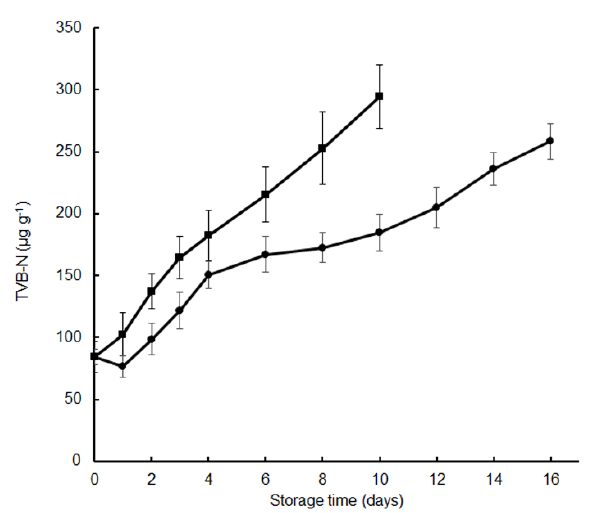
Figure 2. Changes in total volatile basic nitrogen (TVB-N) of crisp grass carp fillets during storage at 4 °C. ▪, distilled water treatments; ●, tea polyphenol